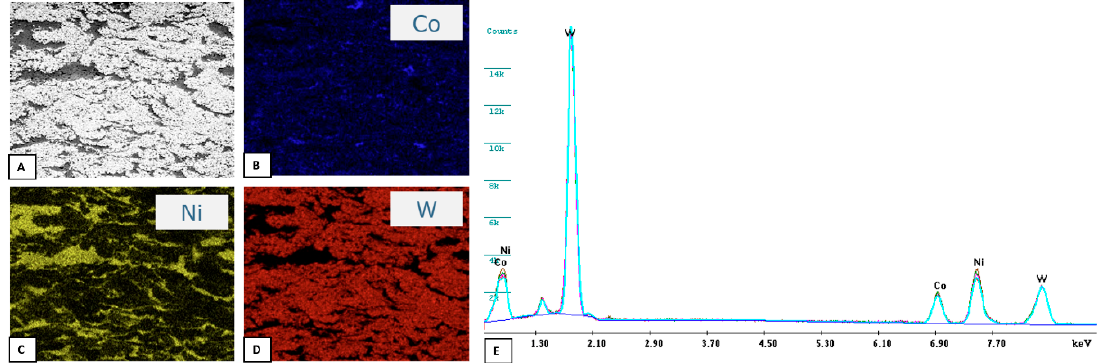
Figure 7. EDS map and spectra overlay of consolidated coupon cold sprayed using decorated 18Ni – 10Co – 72WC. ( A ): secondary electron image of coating cross section; ( B ): cobalt EDS map; ( C ): nickel EDS map; ( D ): tungsten EDS map; ( E ) spectra overlay.